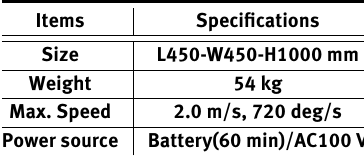
Table 1. HFAMRO-3